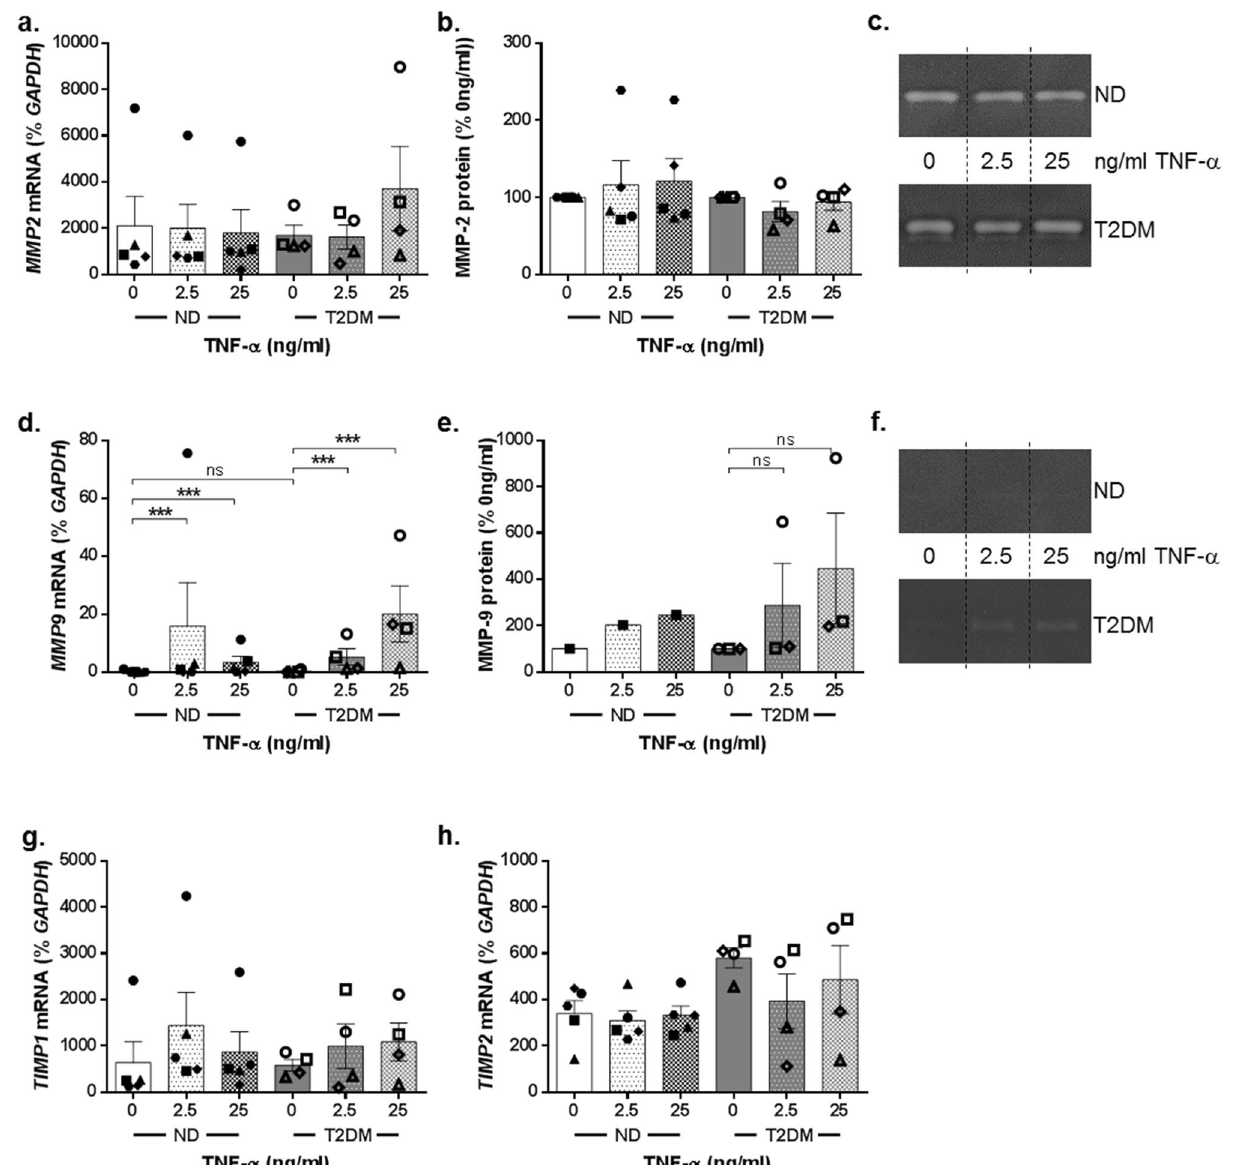
Figure 4. Matrix remodelling in ND-DF and T2DM-DF. ( a ) Cells used in the migration assay were collected and total RNA extracted. MMP2 gene expression was quantified and expressed relative to GAPDH (both n = 4 donors). ( b ) Conditioned media from the migration assays was analysed for MMP-2 secretion using gelatin zymography (both n = 4 donors), ( c ) representative images. ( d ) MMP9 gene expression and ( e – f ) protease activity were analysed using the same method (both n = 4 donors). ( g ) TIMP1 and ( h ) TIMP2 gene activity in the same cells (both n = 4 donors). Two-way ANOVA with Sidak post-hoc test *** P < 0.001, ns =